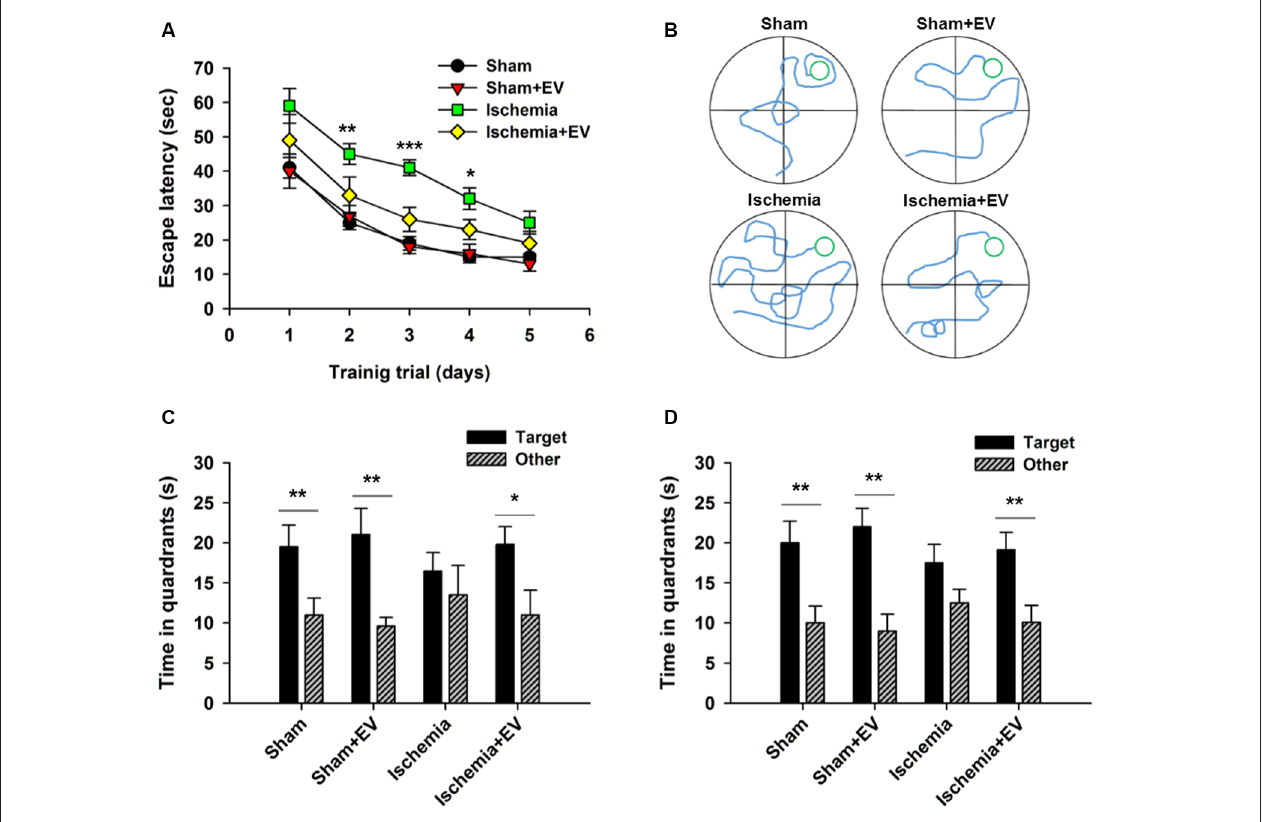
FIGURE 5 | Morris water maze (MWM) test of spatial learning and memory in BMSC-EV treated ischemic mice. (A) Escape latency measured as mean time (s) during training trials (day 2: sham = 25.1 ± 2.1, sham + EV = 26.8 ± 3.3, ischemia = 44.9 ± 3.1, ischemia + EV = 33.5 ± 5.3; day 3: sham = 18.7 ± 2.0, sham + EV = 17.6 ± 2.5, ischemia = 41.1 ± 2.3, ischemia + EV = 16.3 ± 3.5; day 4: sham = 14.8 ± 1.3, sham + EV = 16.8 ± 2.3, ischemia = 31.9 ± 3.1, ischemia + EV = 23.0 ± 2.8). (B) Representative swimming traces of the four groups of mice exhibited the training trial on day 3. (C) Time spent in target quadrant and other quadrants 24 h after the last training trial (sham: 19.5 ± 2.7 and 11.0 ± 2.1; sham + EV: 21.4 ± 3.6 and 9.6 ± 1.1; ischemia: 16.6 ± 2.4 and 13.5 ± 3.7; ischemia + EV: 19.8 ± 2.2 and 10.9 ± 3.1). (D) Time spent in target quadrant and other quadrants tested 7 days later (sham: 19.8 ± 2.6 and 11.6.0 ± 2.1; sham + EV: 22.3 ± 2.3 and 9.1 ± 1.9; ischemia: 17.5 ± 2.4 and 12.3 ± 1.8; ischemia + EV: 19.1 ± 2.5 and 10.8 ± 3.1). n = 12 per group. Data show means ± SEM. Two-way ANOVA analysis followed by a Tukey’s post hoc test for (A) . Student’s t -test for (C,D) . ∗ p < 0.05, ∗∗ p < 0.01 and ∗∗∗ p <